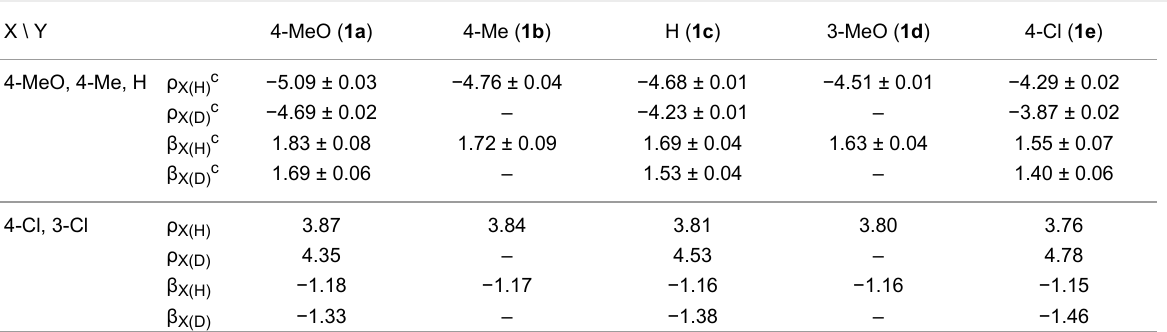
Table 2: Hammett ( ρ X(H and D) ) a and Brönsted ( β X(H and D) ) b coefficients with X for the reactions of Y-aryl phenyl isothiocyanophosphates with XC 6 H 4 NH 2 (D 2 ) in MeCN at 55.0